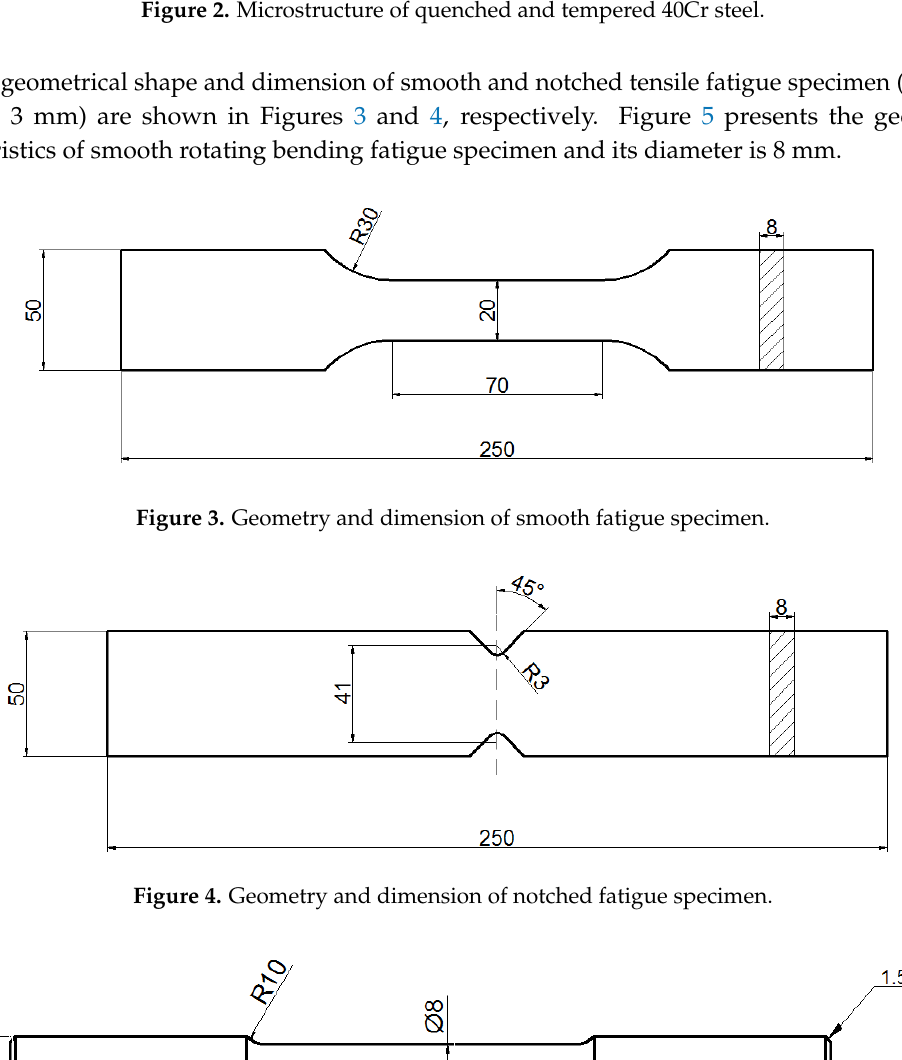
Figure 5. Geometry and dimension of smooth rotating bending fatigue specimen.